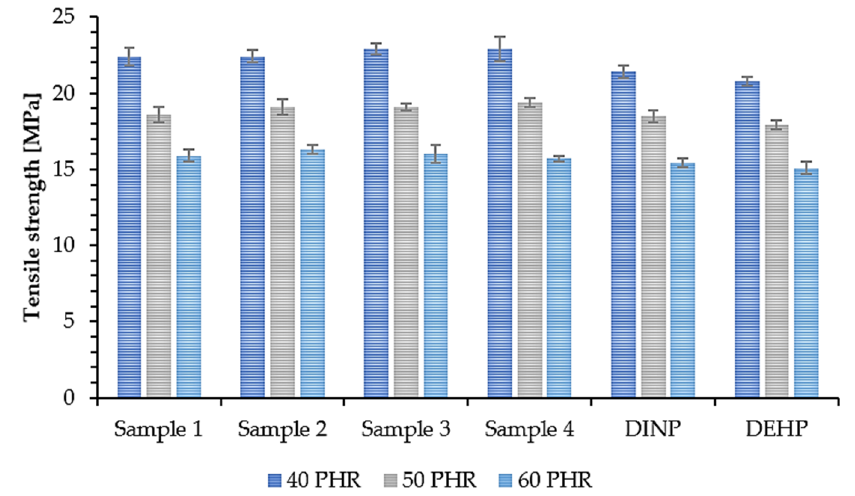
Figure 9. Tensile strength of soft PVC samples.